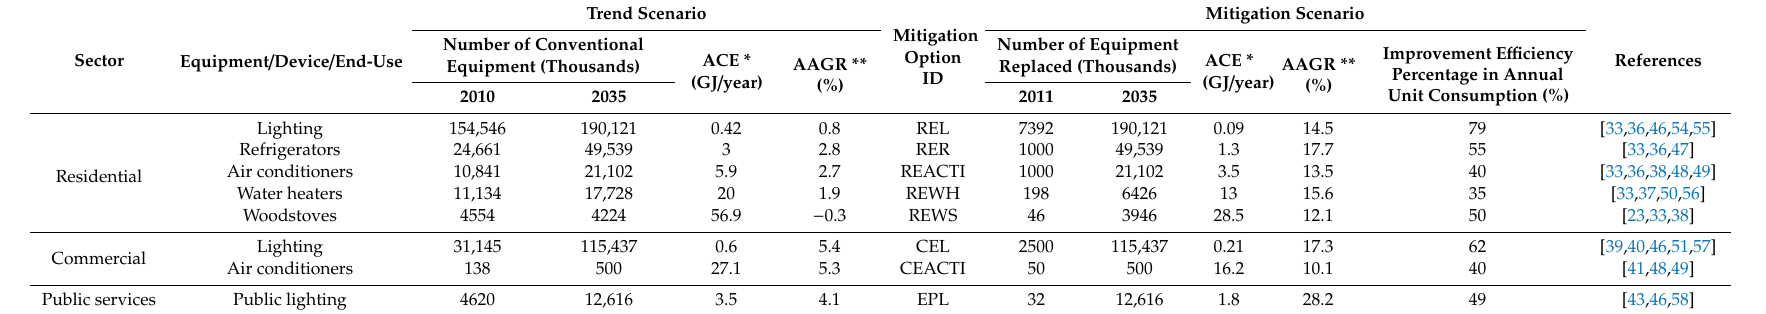
Table 2. Specific assumptions of the energy e ffi ciency options in the mitigation scenario.